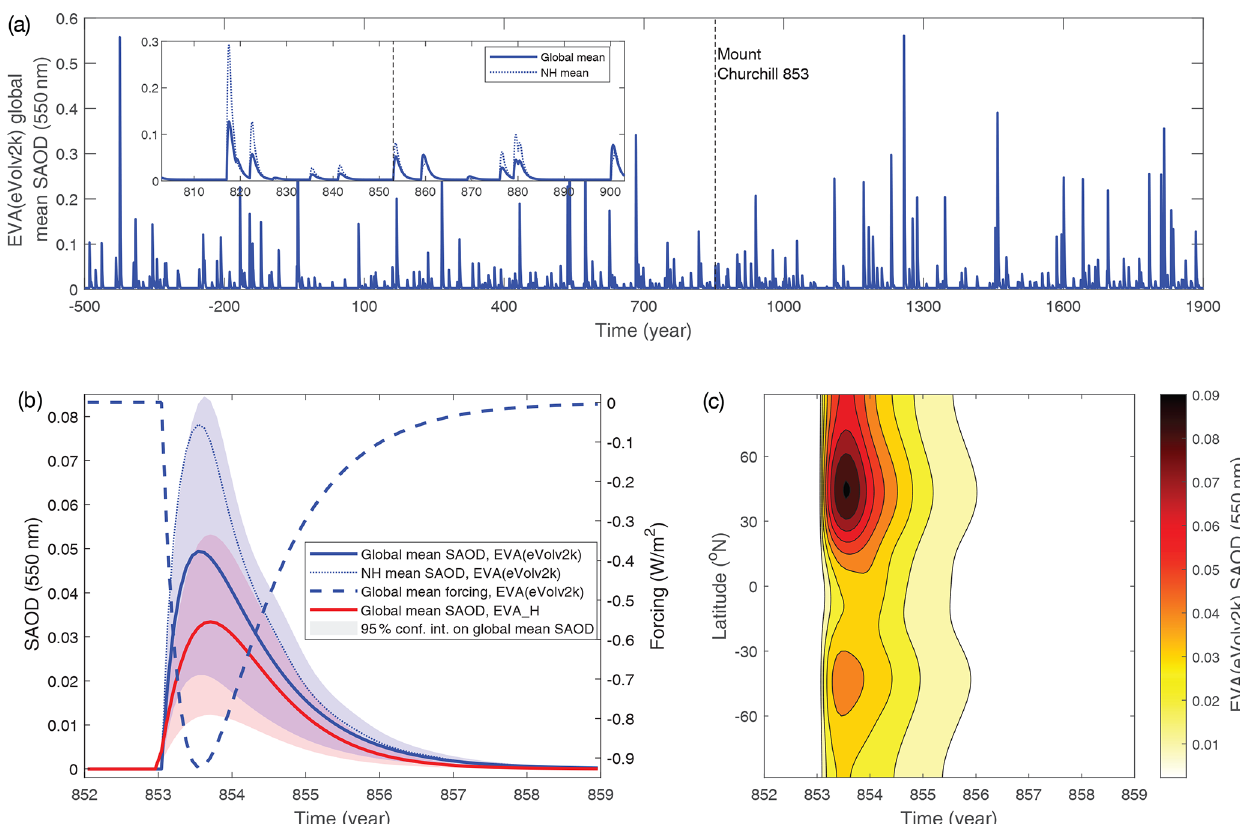
Figure 3. Stratospheric aerosol optical depth (SAOD, 550nm) reconstructed for the Churchill 852/3 eruption. (a) The 500BCE–1900CE EVA(eVolv2k) reconstructed global mean SAOD, with the inset showing details for the 803–903 period and both the global mean and North Hemisphere (NH) mean SAOD. (b) The same time series for the 852–859CE period, during which the Churchill 852/3 eruption is clearly seen. This panel also shows the global mean radiative forcing reconstructed from the EVA(eVolv2k) SAOD and an alternative SAOD reconstruction using the EVA_H model, an extension of EVA that accounts for the SO 2 injection altitude and latitude for reconstructing global mean SAOD. Shadings show 95% confidence intervals on the EVA and EVA_H SAOD reconstructions. (c) Time–latitude evolution of SAOD as reconstructed with